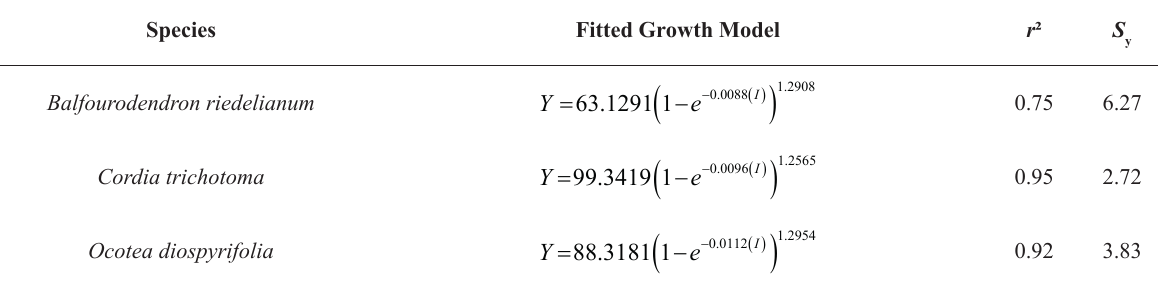
Fitted growth models for three forest species in the Iguaçu National Park. Species Fitted Growth